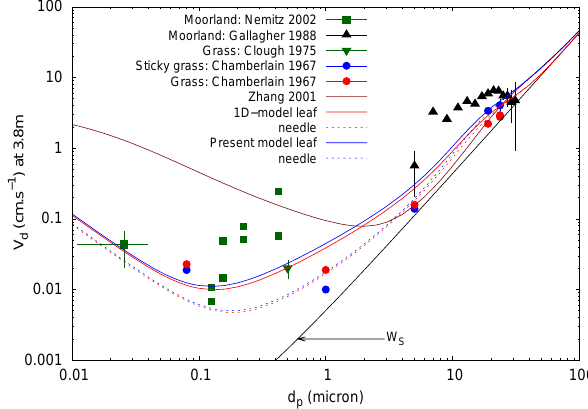
Fig. 2. Comparison of the present model and the 1-D-model under configurations of evergreen needleleaf forest (LUC 4) and short grass (LUC 13, with leaves) for different friction velocity conditions. For the 1-D-model, the crown base height of the forest is taken as h/ 2 and the vertical profile of the leaf surface density as gaussian. Other parameters are given in Table 2. Blue and red plain lines correspond respectively to the present model and the 1-D-model, while the green plain line corresponds to the relative error between them. The black line corresponds to the sedimentation velocity.